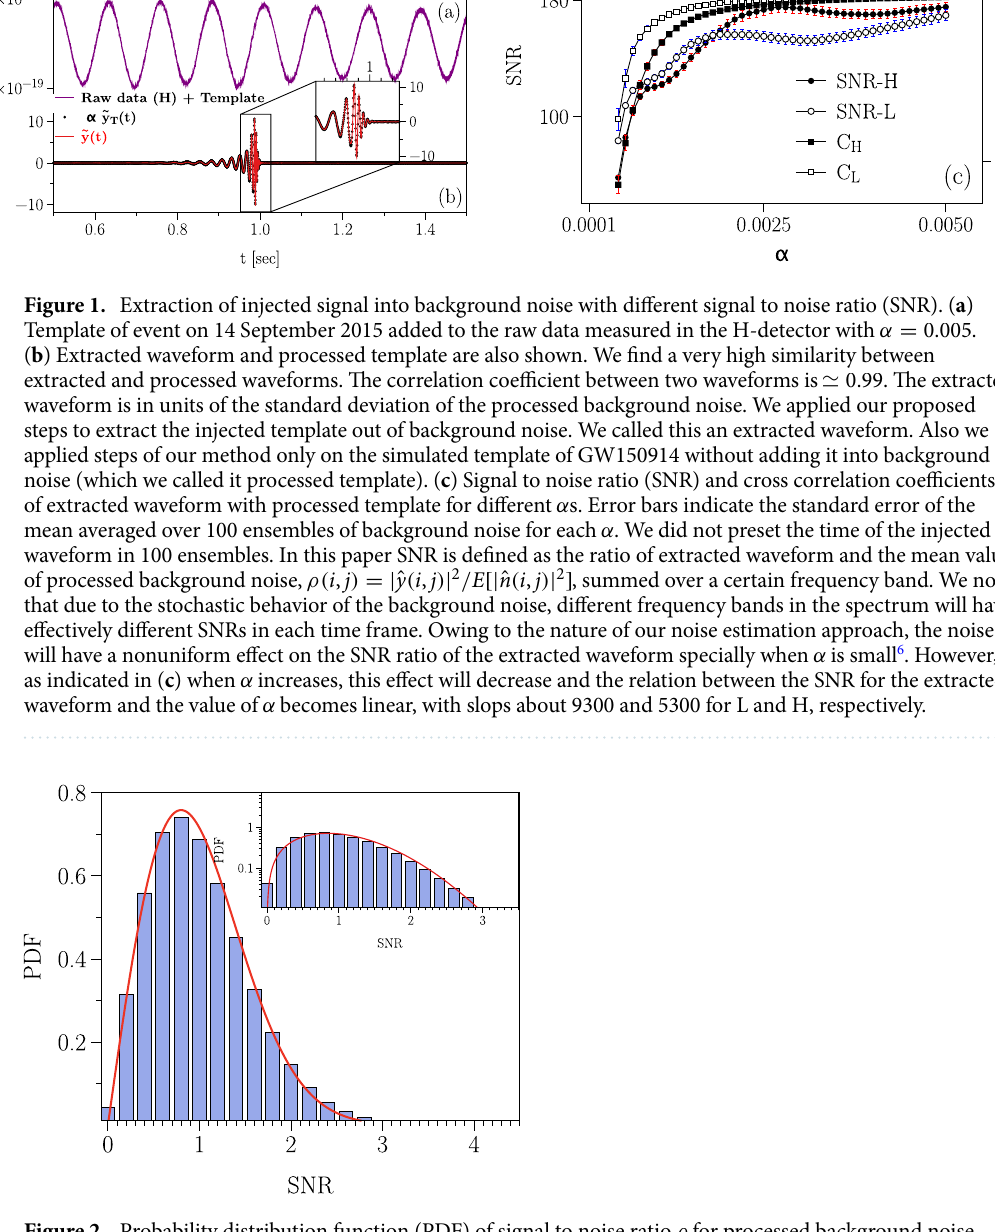
To reduce the false trigger rate, for a given ρ ∗ , we estimate the joint probability p ( [ ρ H , ρ L ] > ρ ∗ ) (i.e. ρ H > ρ ∗ and ρ L > ρ ∗ ) in shifted time-delay between the detectors, by assuming absence of correlated noise between detectors. This gives the rate of false alert for ρ ∗ > 4 to be 1 alert per 200 days of running time 60 . The generali- zation of false alert rate for N-point (N-detector) joint probability p can be found in 60 . By analysing extensive background noise of about 637h of data, we find that the ρ has Rayleigh probability distribution function (see Fig. 2 and details are given in “Materials and methods”). We apply our method to the GW time series in the LIGO public database. In Fig. 3, we plot the extracted wave- forms for GW150914, binary black-hole mergers in H and L detectors. The cross-correlation coefficient between the two extracted waveforms has the value ≃ − 0.92 with a time-lag ≃ 7.3 + 0.3 − 0.5 ms where L-detector received the